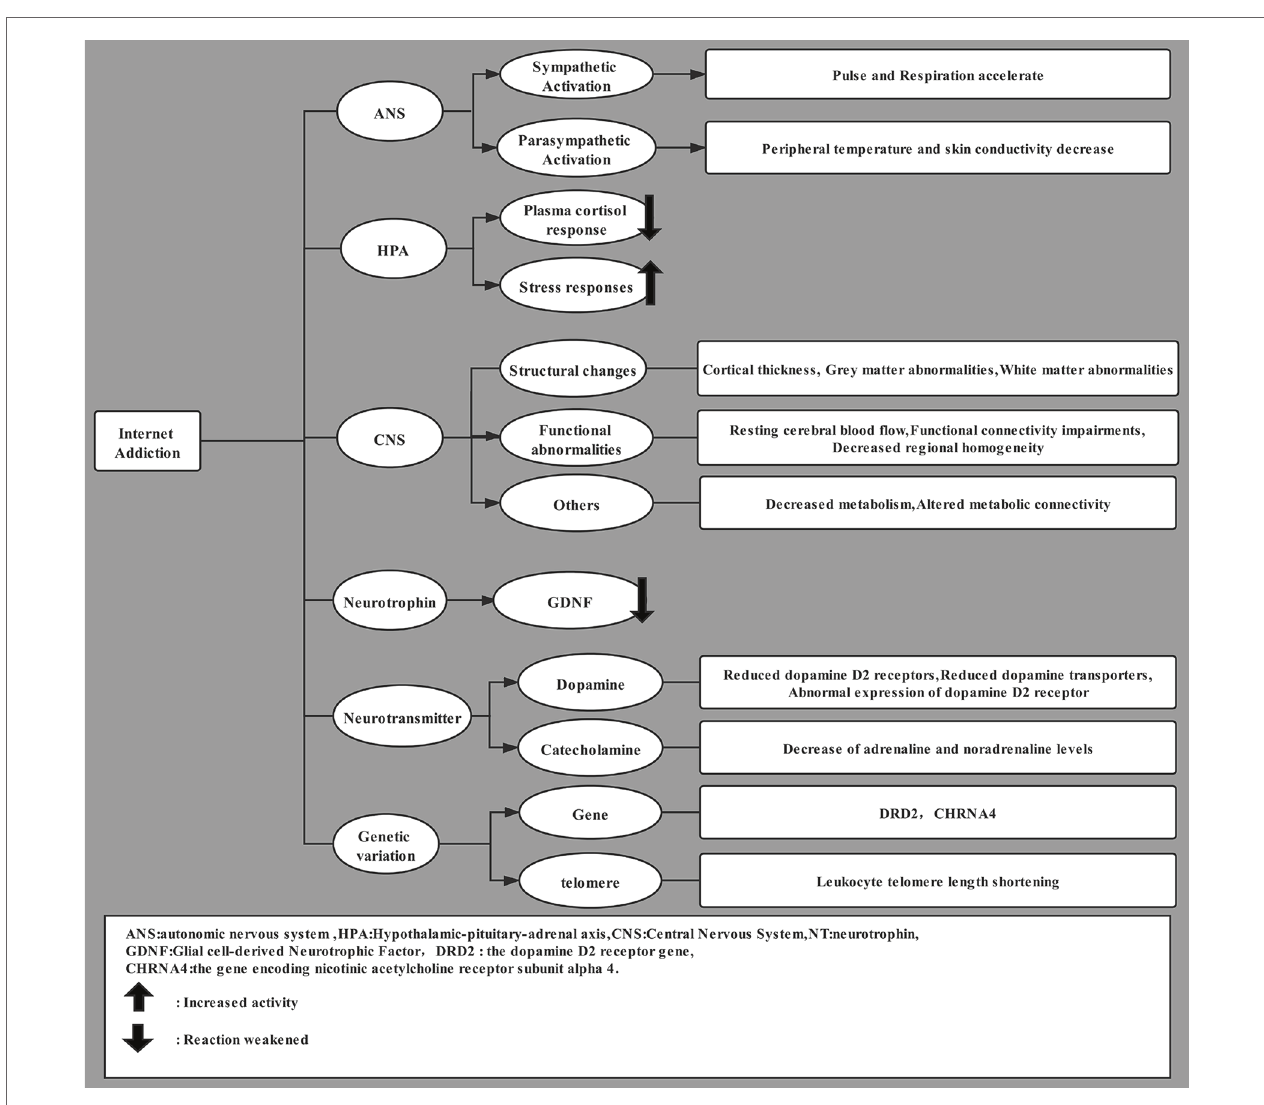
FIGURE 1 | Neurobiological mechanisms of internet